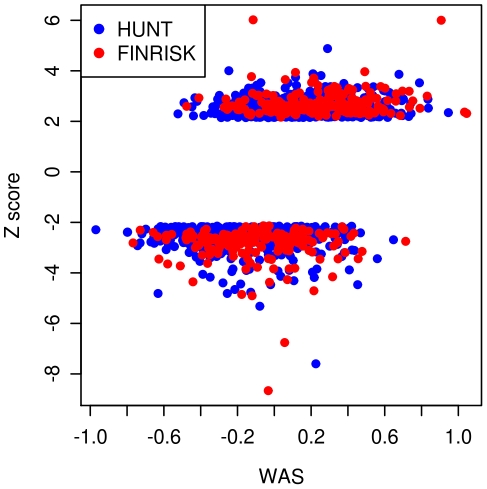
Plot of weighted allele scores (WAS) against Height Z-scores for HUNT and FINRISK cohorts.The plot shows the WAS, a measure of the genetic prediction of height by known common variants, against the height Z-scores. The tall individuals (Z-score>2.14) have generally larger WAS than the short individuals (Z-score<−2.14). Individuals from the HUNT study are labeled blue and individuals from the FINRISK study are labeled red.